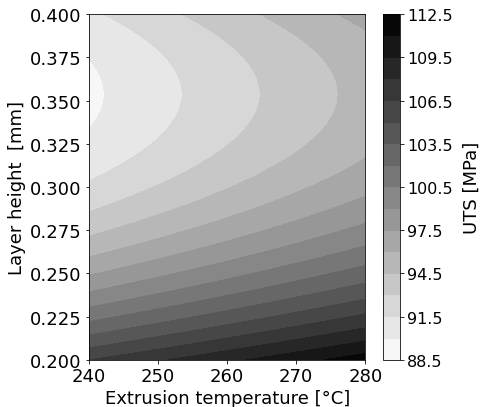
Figure A2. Contour plot for T ext and h based on DoE prediction model.